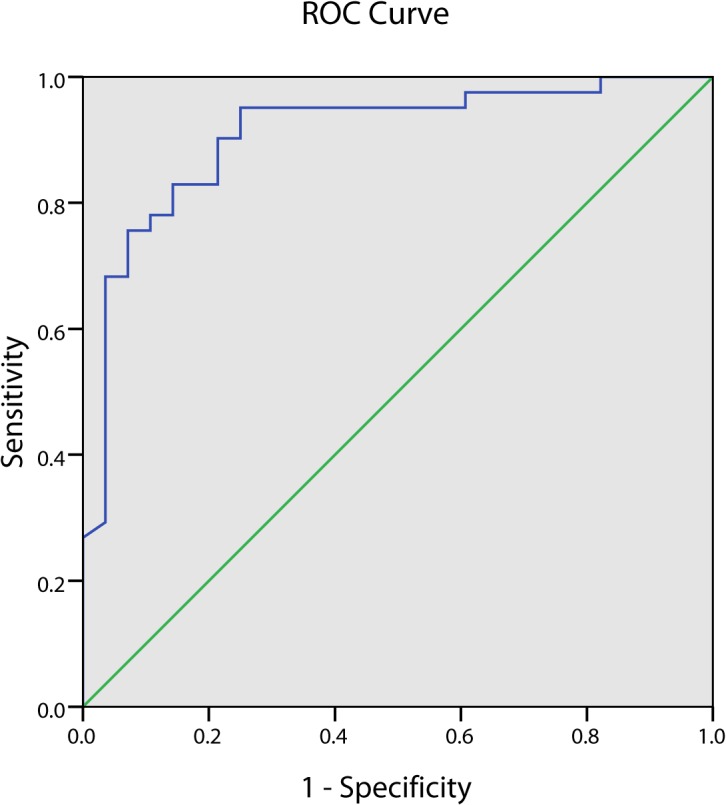
The ROC curve for SNRmean to predict VP of group B at 96h.Area under the curve (AUC) was 0.908 (P = 0.000).The cutoff value was 23.9.